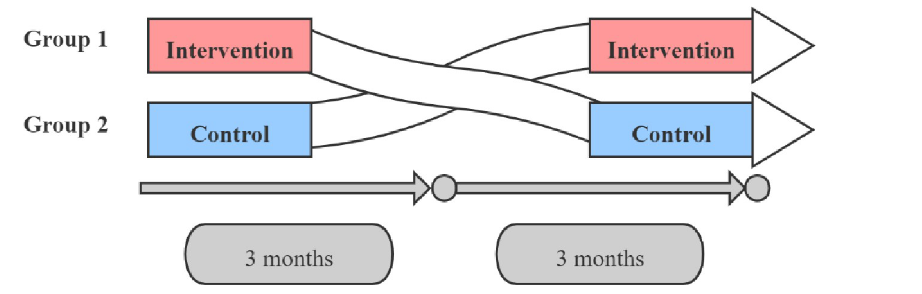
Fig 2. Cross-over trial diagram.